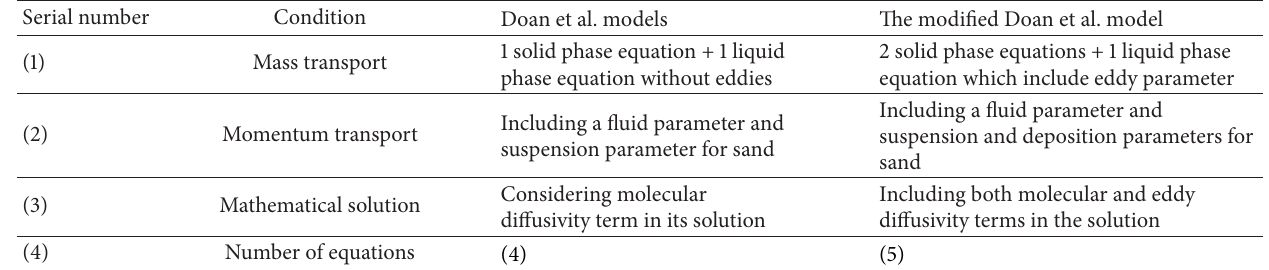
Table 2: Similarities and differences between the new model and Doan et al.’s